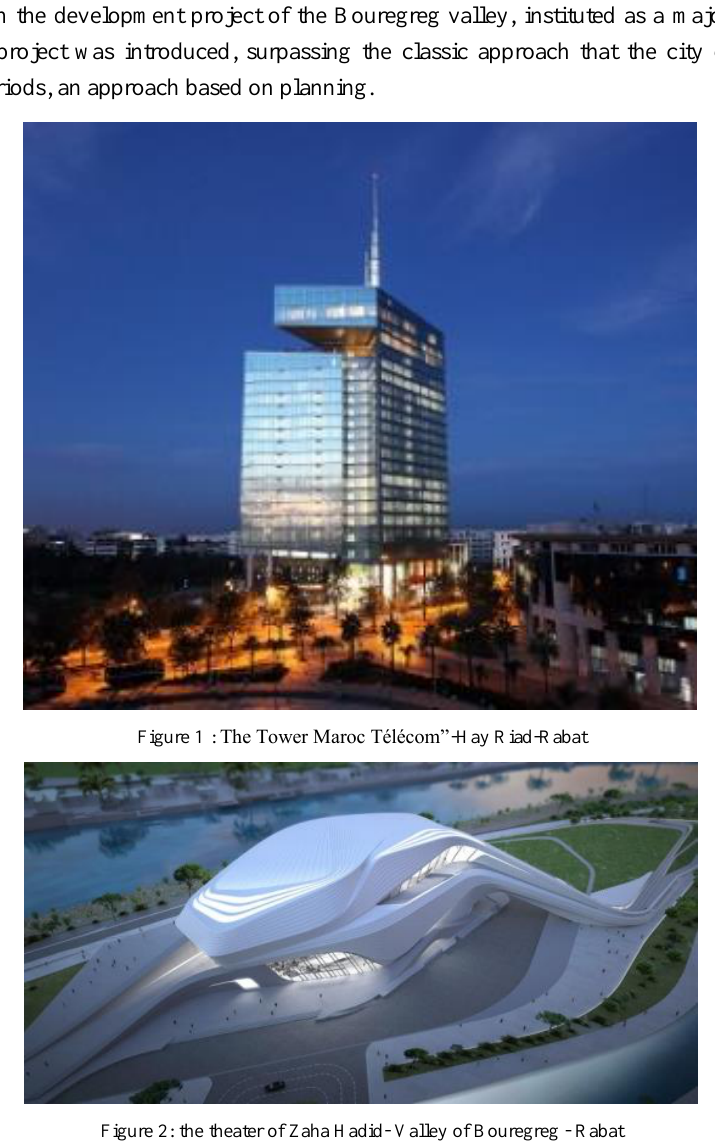
Figure 2: the theater of Zaha Hadid- Valley of Bouregreg - Rabat